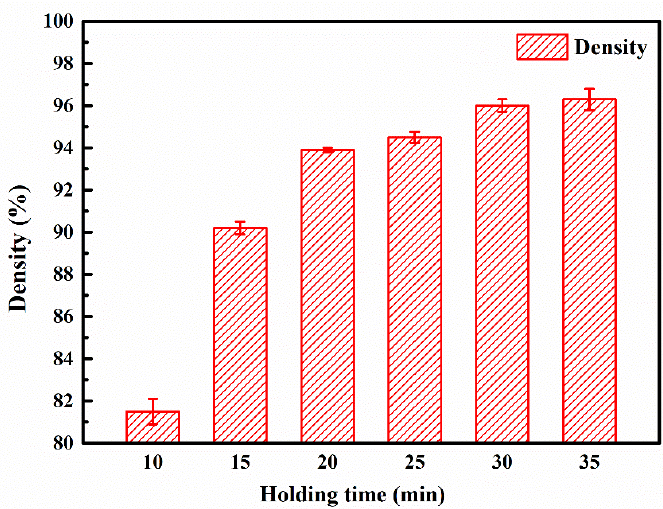
Figure 5. The relationship between relative density and holding time in the 45 vol.% AlN/Al.